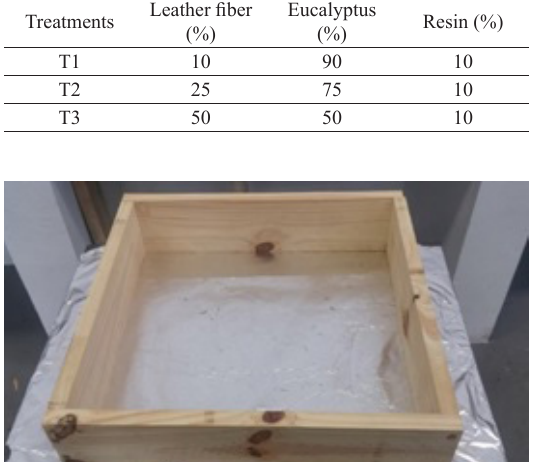
Table 1 – Proposed treatments to production the particleboards.